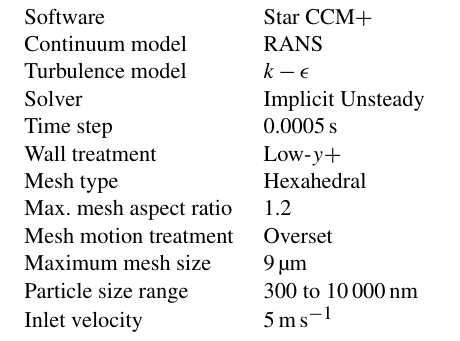
Figure 7. CFD–LPT results for the ratio of particle mass flux at the top of the domain to particle mass flux through planes with varying z coordinates. Each line represents the mass flux through an annular region with a lower radius described in the key. The size of particle for this simulation is 300nm.